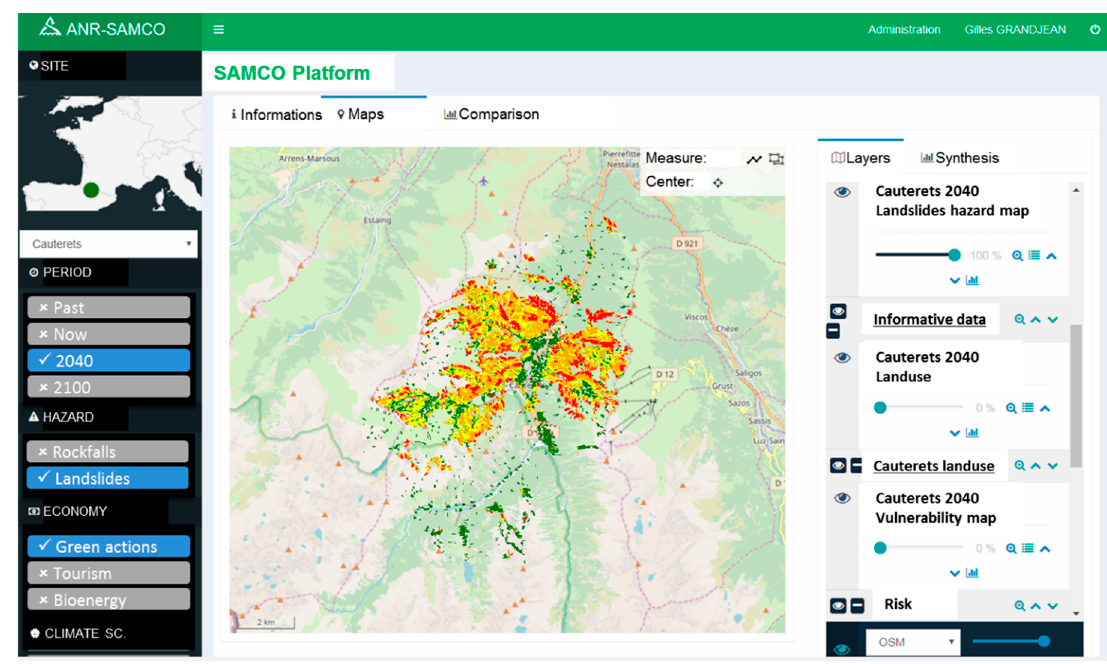
Figure 6. “Print screen” of the SAMCO Web-platform showing the landslide hazard map for the scenario: Site = Cauterets, Period = 2040, Hazard = Landslides, Economy = Green actions, climate = RCP4.5 (not visible on the screen).